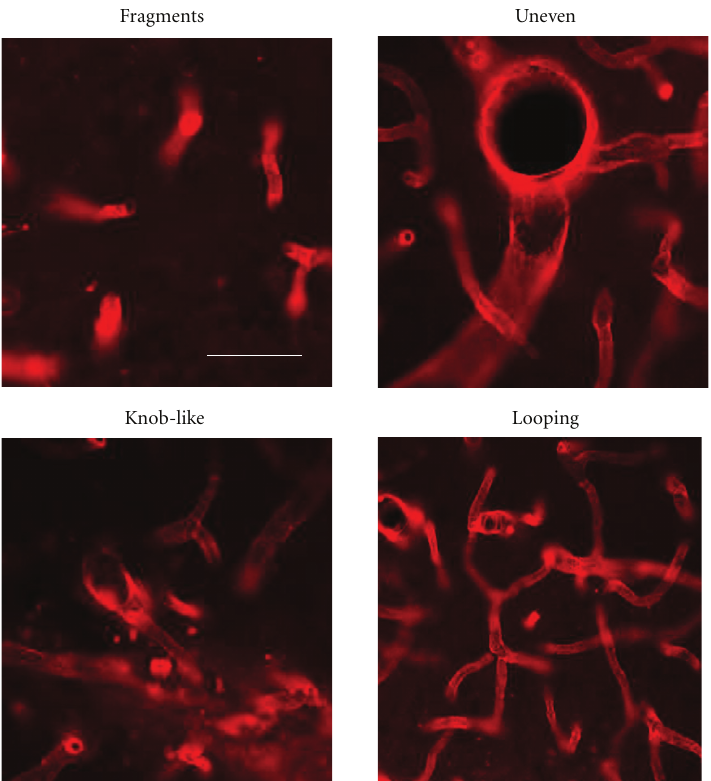
Figure 2: Morphology of microvessels stained with RECA-1 in A β 1 − 42 -injected hippocampus. Panels show morphological features including fragments, looping microvessels, and vessels with knob-like and uneven diameters. The scale bar represents 40 μ